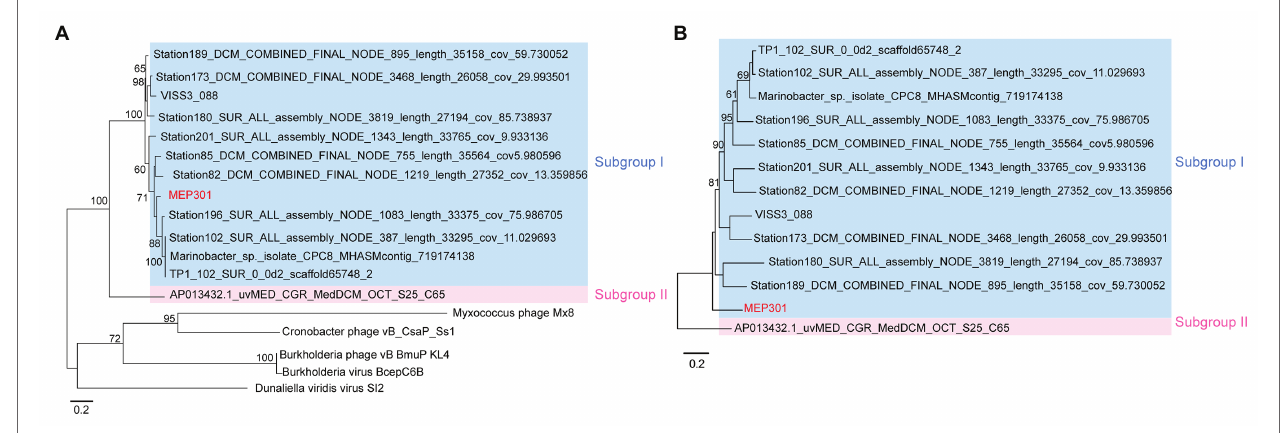
FIGURE 3 | (A) Phylogenetic analysis of TerL protein sequence identified from MEP301 and 12 MEP301-type metagenomic viral sequences (MVGs). (B) Phylogenomic tree of the MEP301-type genomes at the amino acid levels constructed by VICTOR web